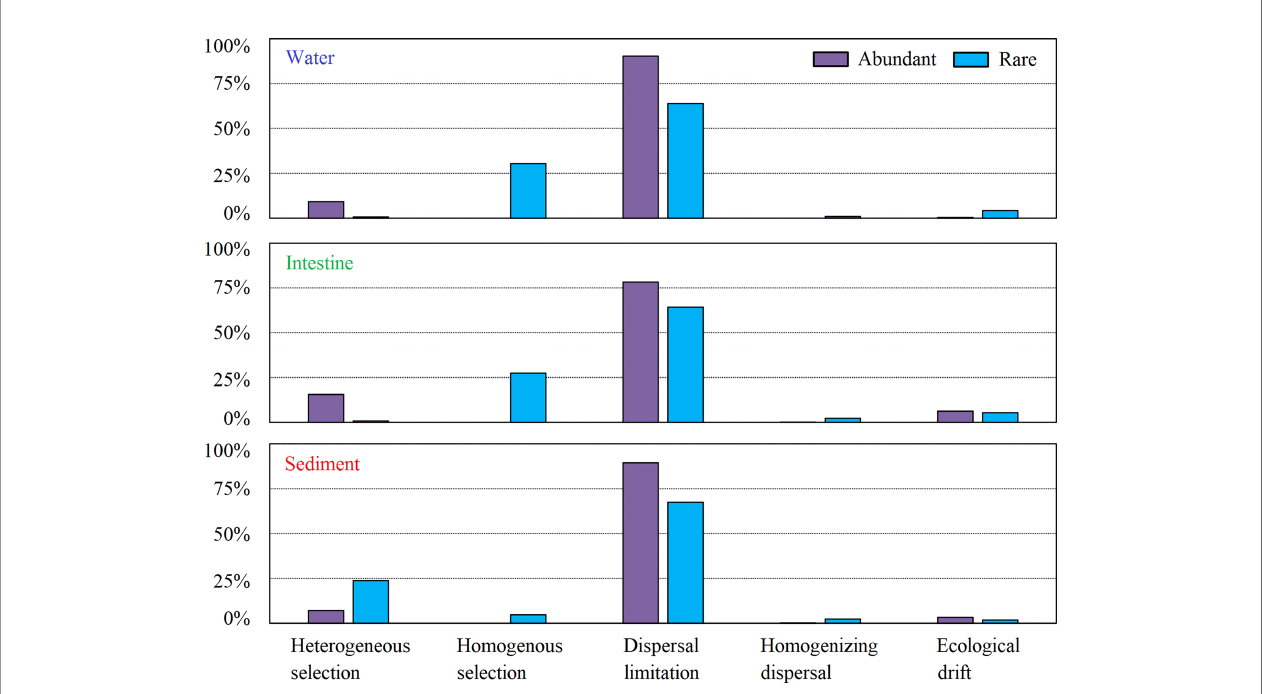
FIGURE 4 | Microbial assembly mechanisms of abundant and rare community of three habitats in the shrimp cultural